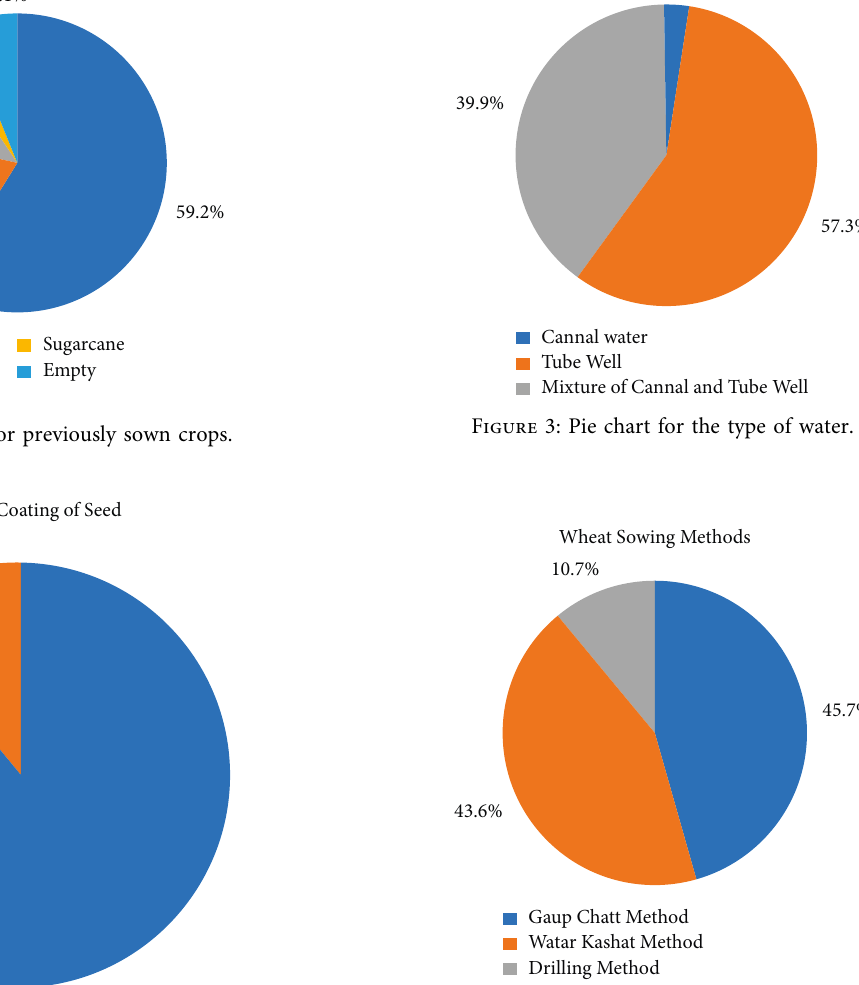
Figure 4: Pie chart for wheat sowing methods.